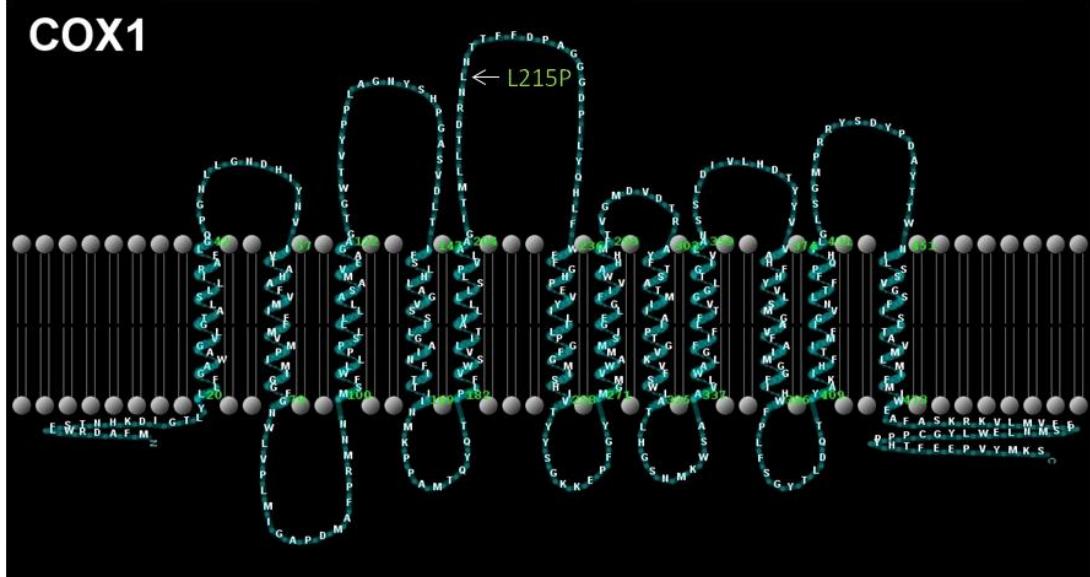
Figure 6. Localization of the m.6547T>C (p.L251P) on the MT-CO1. The biochemical activity of the CO1 subunit of complex IV is deficient in patient